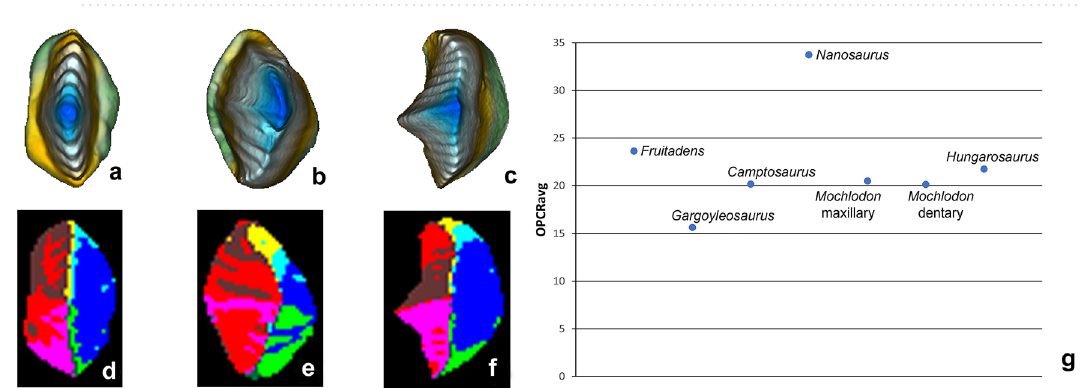
Figure 6. OPCR maps and average dental complexity of the unworn teeth of Hungarosaurus tormai and Mochlodon vorosi in relation to other ornithischians. Data for the latter taxa are taken from 20 ; note that here data were calculated with the 3D OPCR method]. ( a , d ) Hungarosaurus tormai ; ( b , e ) Mochlodon vorosi maxillary tooth; ( c , f ) Mochlodon vorosi dentary tooth. Note that OPCR values for Hungarosaurus tormai and Mochlodon vorosi are calculated only for one complete tooth. ( g ) Average dental complexity of the unworn teeth of Hungarosaurus tormai and Mochlodon vorosi in relation to other